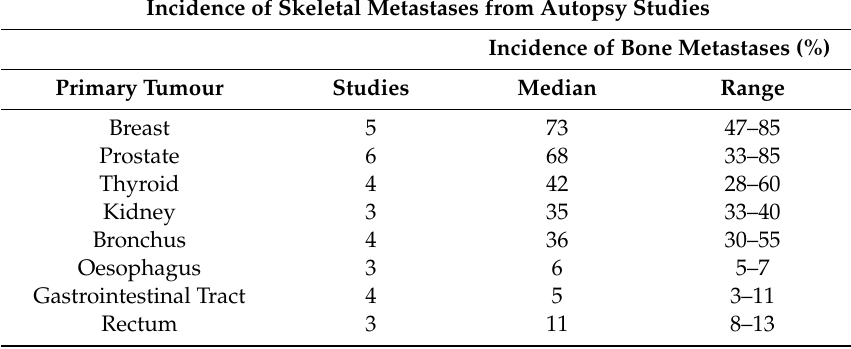
Table 1. Incidence of skeletal metastases within bone-metastatic cancers. Incidence of Skeletal Metastases from Autopsy